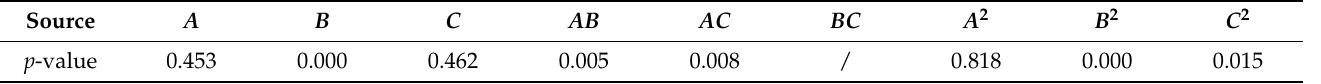
Table 8. The p-value of each coefficient in regression model for contour parameters.